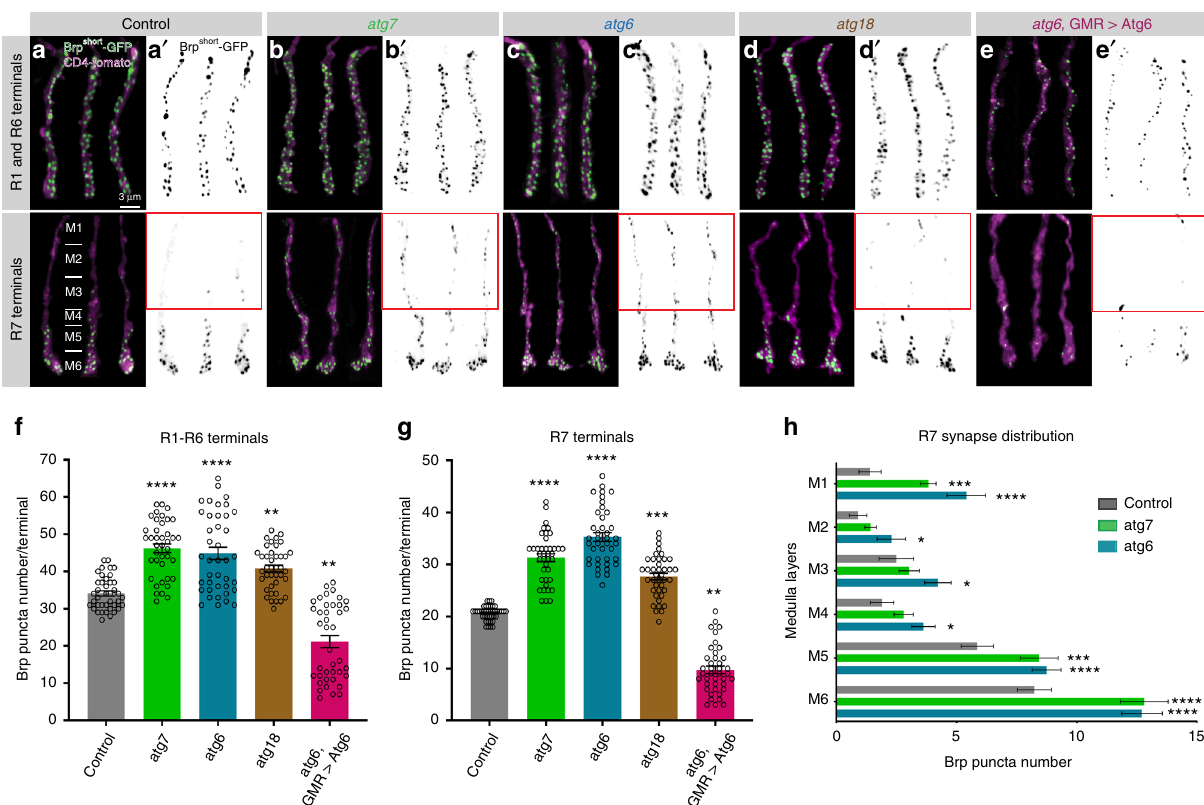
Fig. 2 Autophagy-de fi cient Drosophila photoreceptors form supernumerary synapses. a – e ’ Representative images of R1 – R6 and R7 photoreceptor axon terminals with Brp short- GFP marked active zones in wild-type ( a , a ’ ), atg7 mutant ( b , b ’ ), atg6 mutant ( c , c ’ ), atg18 mutant ( d , d ’ ), and atg6 , GMR > Atg6 ( e , e ’ ). R7 axon terminals are shown from distal (top) to proximal (bottom) medulla. Relative thicknesses of medulla layers are shown in Control R7 terminals panel ( a ) along R7 axon terminals. Red boxes show supernumerary synapses in loss of autophagy at distal part of R7 axon terminals. Repeated fi ve to ten times independently with similar results. f , g Number of Brp puncta per terminal in R1-R6 ( f ) and R7 ( g ) photoreceptors. n = 40 terminals per condition. Kruskal – Wallis and Dunn ’ s as post-hoc test; ** p < 0.01, *** p < 0.001, **** p < 0.0001. Error bars denote mean ± SEM. h Number of Brp puncta in distinct medulla layers along R7 axon terminals (see Methods for the de fi nition of medulla layers and a for relative thicknesses of medulla layers). n = 22 terminals for control, n = 30 terminals for atg7 , n = 27 terminals for atg6 . Kruskal – Wallis and Dunn ’ s as post-hoc test; * p < 0.05, *** p < 0.001, **** p